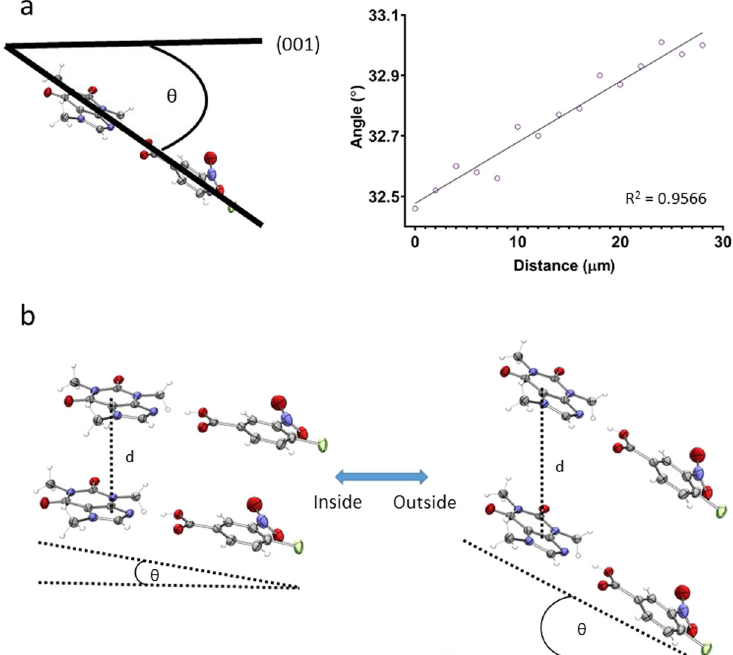
Fig. 2 Proposed mechanism of elastic fl exibility in co-crystals of 1. a The change in angle between the mean plane of the hydrogen-bonded dimer and the (001) plane moving from the inside to the outside of the bend. b Rotation compared to the (001) face and movement apart within the π -stack (d) facilitates the required cell deformation. Δ d = 0.04 Å, Δθ = 0.54°. Disorder in the nitro-group is removed for